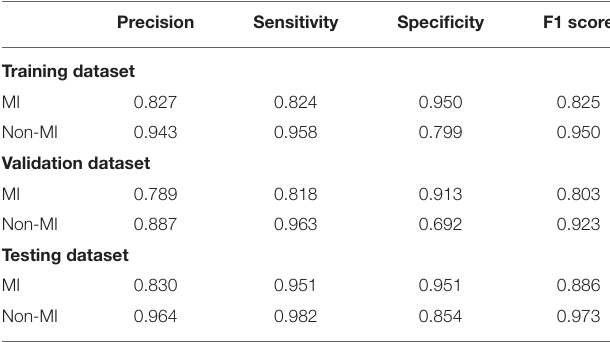
TABLE 2 | The precision, sensitivity, specificity, and F1 scores of the deep learning model on the different datasets.